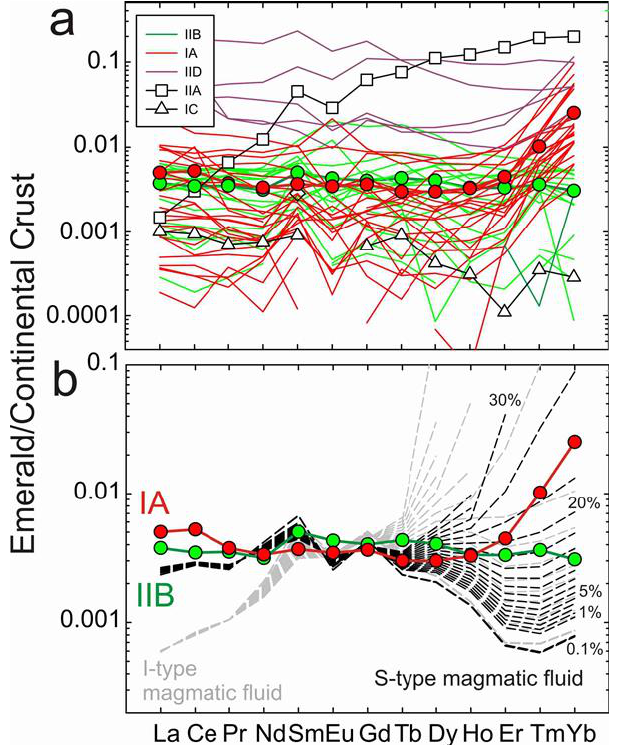
Figure 7. Emerald formation and the REE; ( a ) rare earth element patterns of major emerald types (IIB, IA IID, IIA, IC); ( b ) the formation of emeralds from S-type magmatic fluid compositions, rather than I-type granitic fluid compositions. Compositions of magmatic fluids were modelled using initial chemical/modal constituents from [43] , and trace-element partitioning from [44,45] . Batch melting followed by fractional crystallization was used to produce resultant melts and fluids. Elements are ordered by relative incompatibility and normalized to continental crust composition [28]. Details of the model are provided in the text.